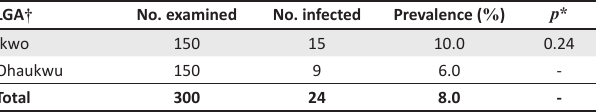
TABLE 1: Prevalence of urinary schistosomiasis in Ohaukwu and Ikwo, Nigeria, December 2016. LGA †